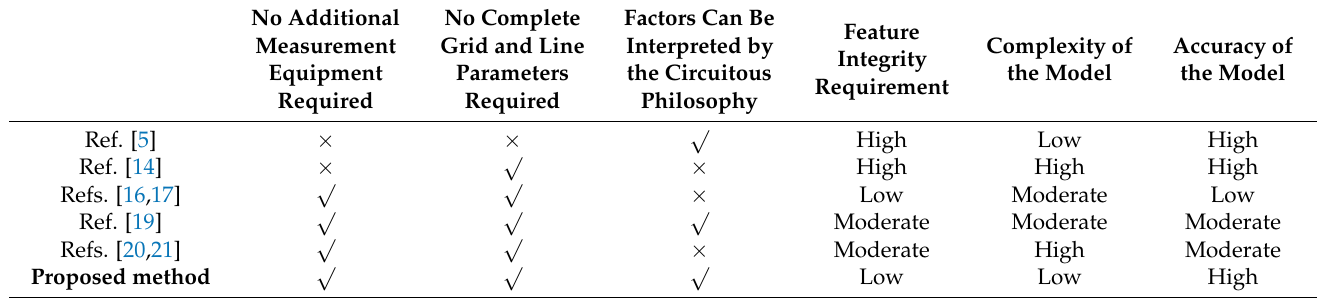
Table 1. Comparison of proposed method with existing methods to calculate theoretical line